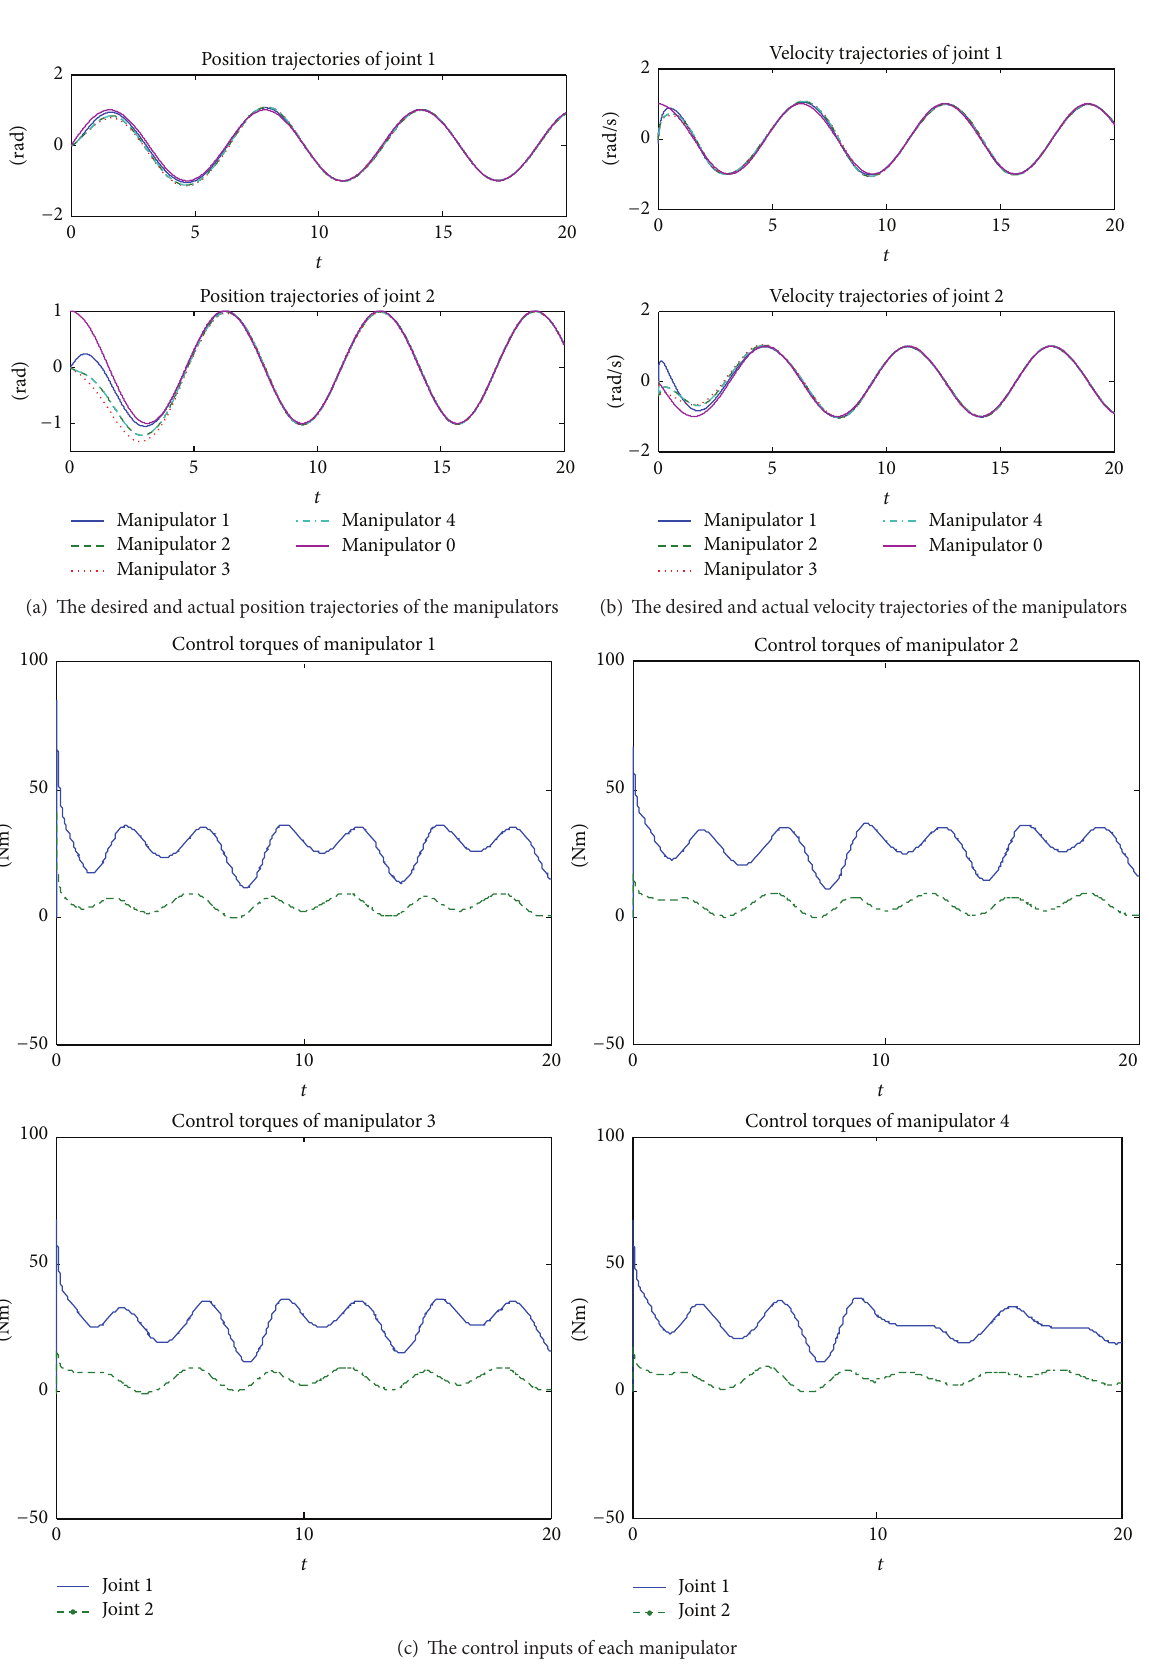
Figure 4: Simulation results with the actuator faults under the